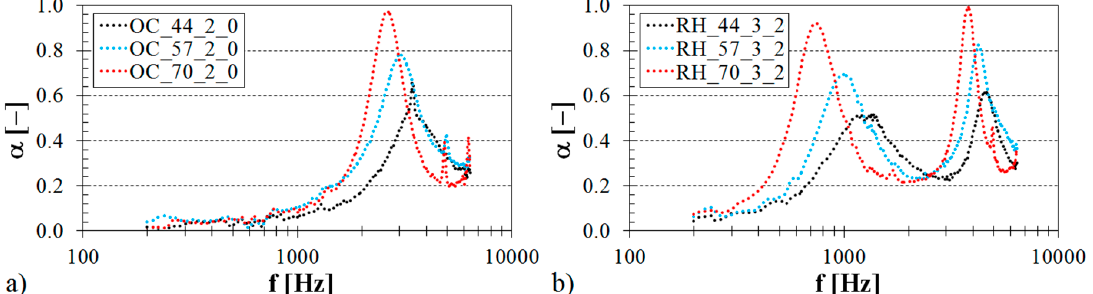
Figure 4. Influence of the sample volume ratio on the frequency dependencies of the sound absorption coefficient for the tested ABS samples: ( a ) Octagonal structure, sample thickness t = 2 cm, air space size a = 0 cm; ( b ) Rhomboid structure, sample thickness t = 3 cm, air space size a = 2 cm.